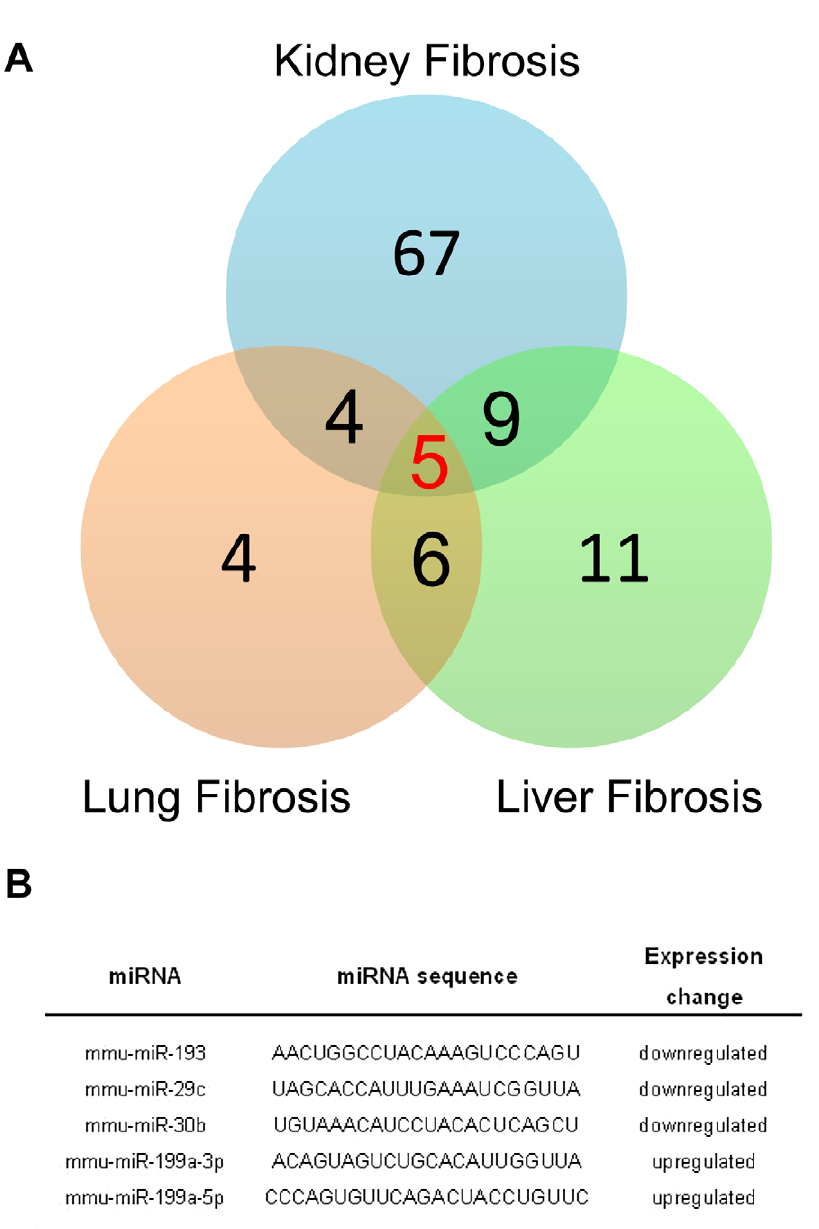
Figure 9. MiR-199a-5p is commonly dysregulated in three experimental mouse models of liver, lung, and kidney fibrosis. (A) Venn diagram showing the relationships of miRNA expression changes in lungs from C57BL/6 14 days after Bleomycin treatment (n=4 mice), livers from BALB/C mice 6 weeks after CCl 4 administration (n=5 mice) and kidneys from C57BL/6 mice 28 days following unilateral ureteral obstruction (n=4 mice). The numbers of miRNAs whose expression was differentially detected in each mouse model at p , 0.01 are shown. Data on liver fibrosis are from (17). (B) List of the 5 miRNAs dysregulated in the three experimental models of fibrosis. ttest, p , 0.01.